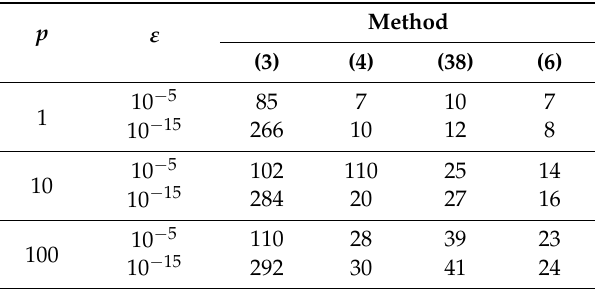
Table 1. Numbers of iterations for solving system of Equation